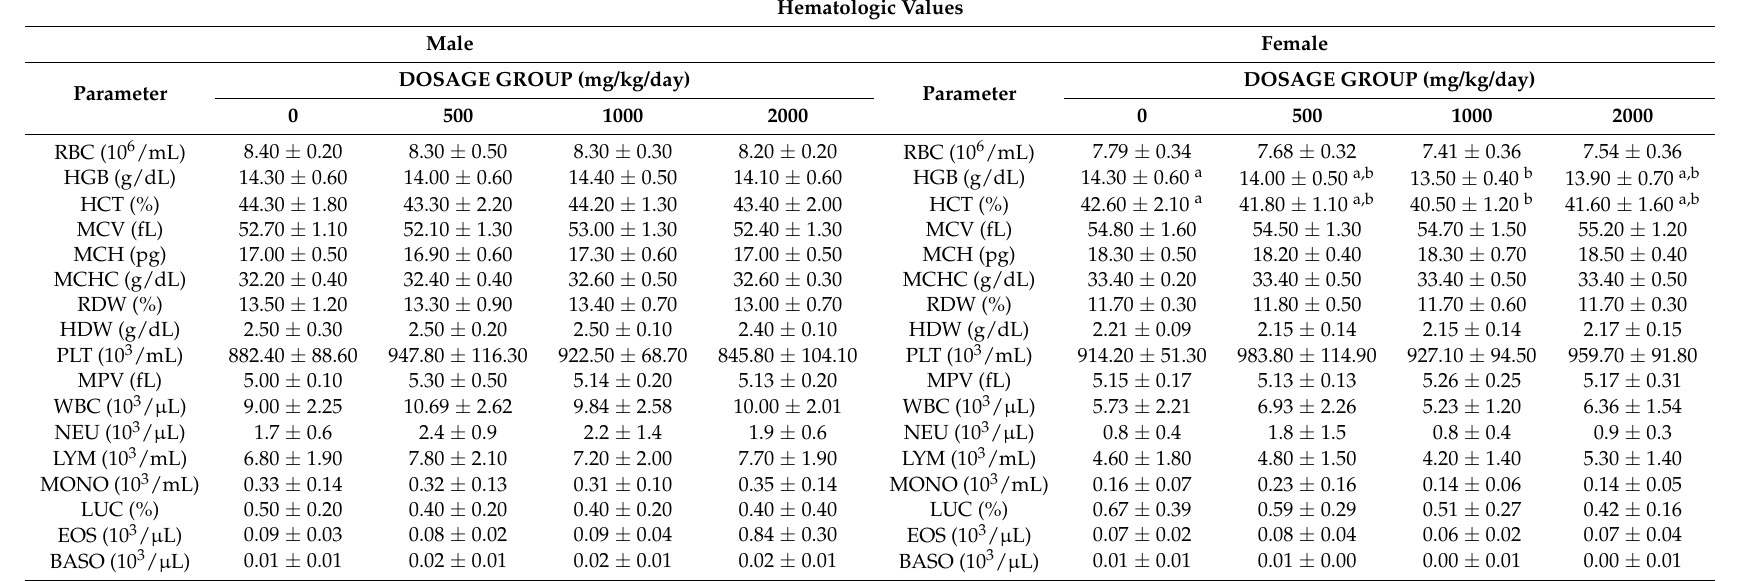
Table 6. Hematologic values in male and female rats given 500, 1000, or 2000 mg/kg/day GEE for 13 weeks in a repeated oral dose toxicity study.